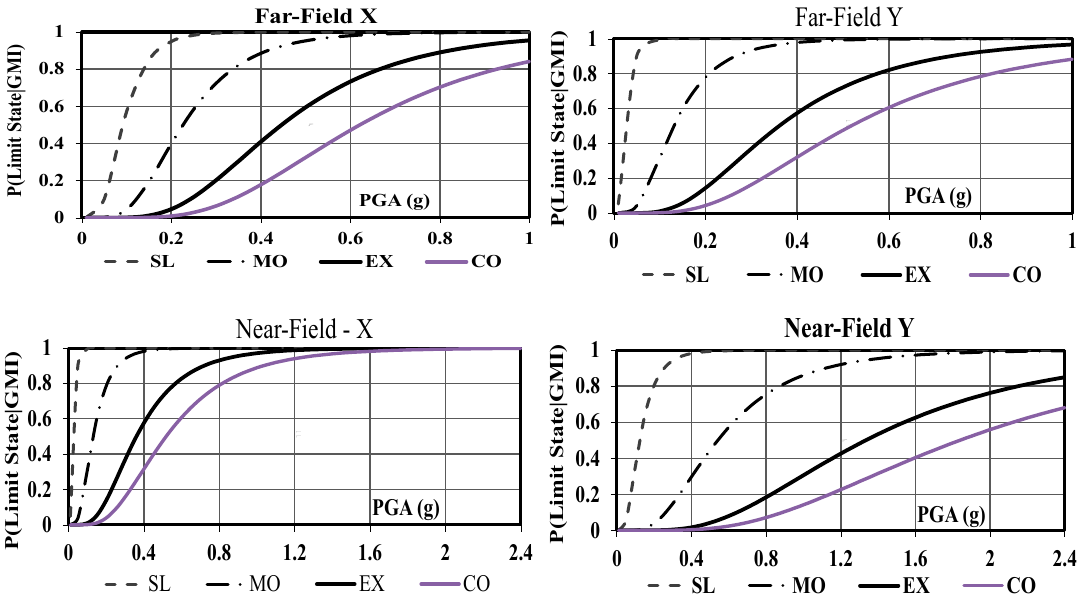
Figure 19. Fragility curves of bridge bent CD demands using far-field ( top ) and near-source ( bottom ) input ground motions in the longitudinal ( left ) and transverse ( right ) directions of the benchmark bridge.